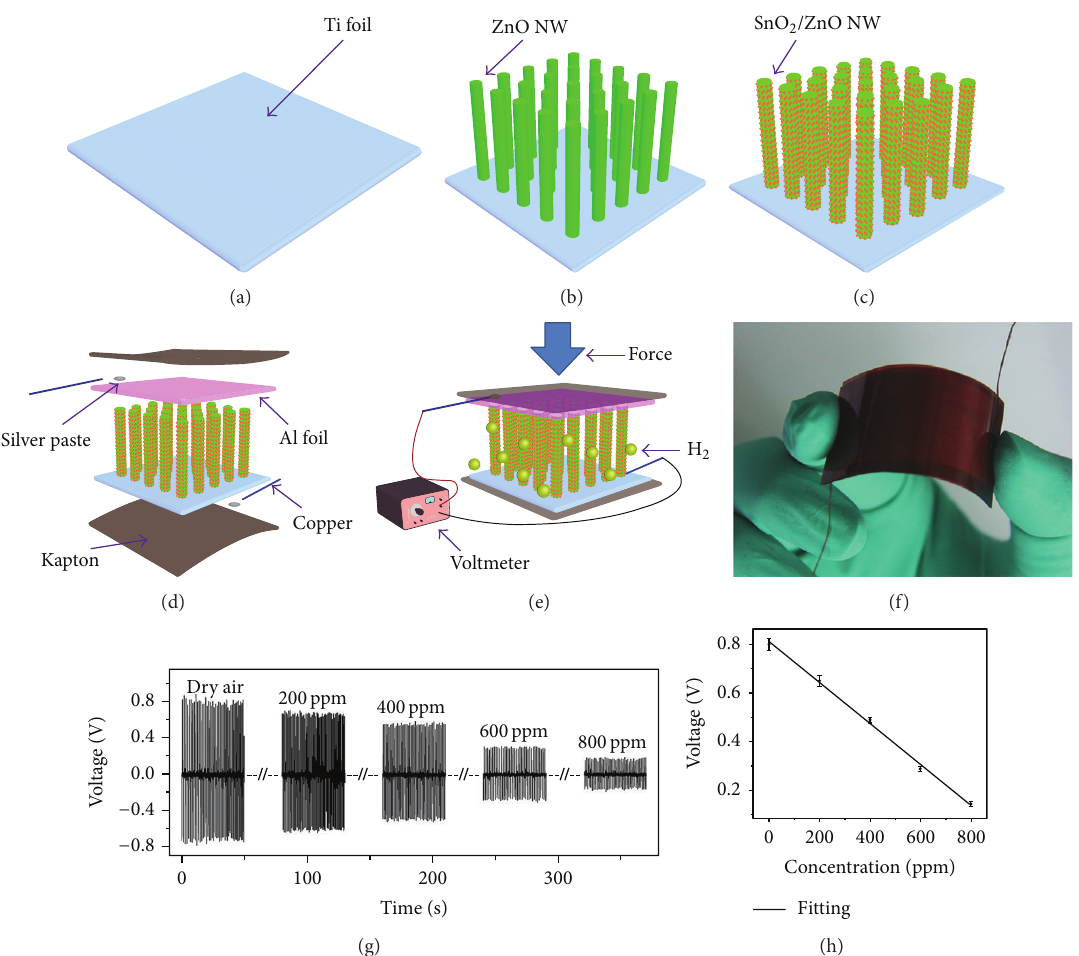
Figure 14: The active H 2 sensors based on ZnO VINGs. ((a)–(e)) The schematic diagram of the synthesis process and working mechanism of the sensor. (f) A photograph of the as-fabricated sensor. (g) The output voltage of the sensor with exposure to different concentration of hydrogen gas. (h) The linear relationship between the hydrogen concentration and output voltage. (Reproduced from [16] with the permission from